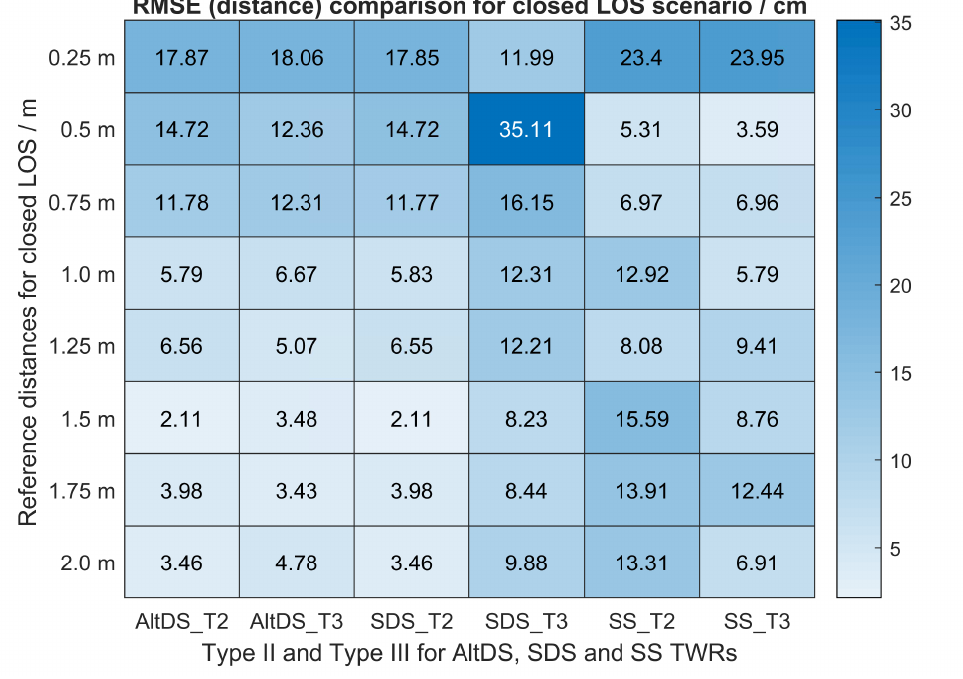
Figure 12. Measured distance error (RMSE) comparison of Types II and III for three TWRs in a close LOS